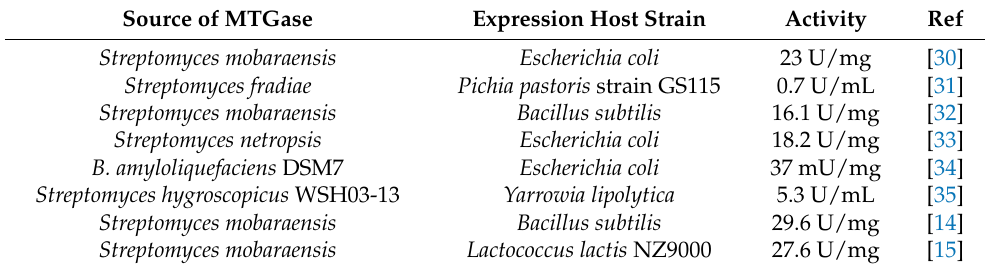
Table 3. Comparison of heterologous expression MTGases from different